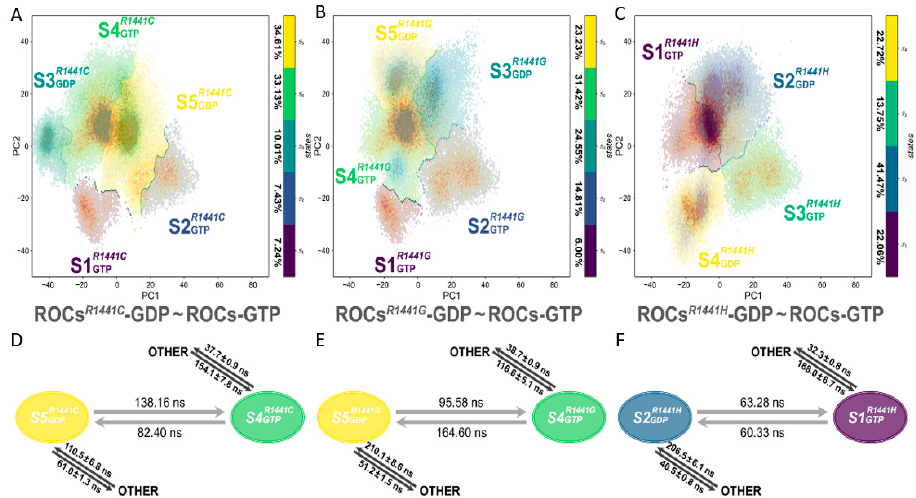
Figure 5. Distribution of metastable states in ( A ) ROCs R1441C -GDP~ROCs-GTP (5 macrostates), ( B ) ROCs R1441G -GDP~ROCs-GTP (5 macrostates), and ( C ) ROCs R1441H -GDP~ROCs-GTP (4 macrostates) MSM. The type of nucleotide ligand for ROCs is indicated with subscripts, and the percentage of each macrostate is shown beside the corresponding colormap. MFPT between the predominant GDP-bound ROCs mutant and GTP-bound ROCs calculated in ( D ) ROCs R1441C -GDP~ROCs-GTP, ( E ) ROCs R1441G -GDP~ROCs-GTP, and ( F ) ROCs R1441H -GDP~ROCs-GTP MSM. The two-ended black arrow between metastables and OTHER denoted the transition between the implicated macrostates and all other remaining metastable states in the corresponding MSM.